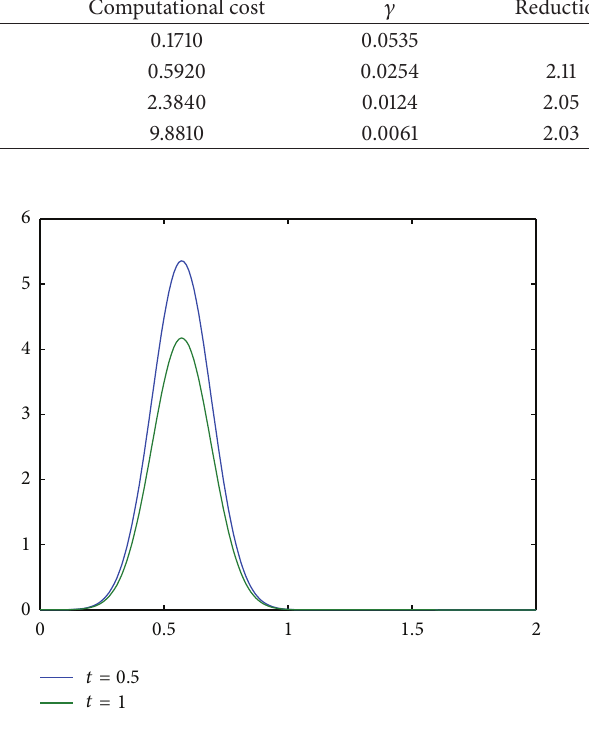
Figure 2: The exact solution 𝑝 . Figure 3: The exact solution 𝑐